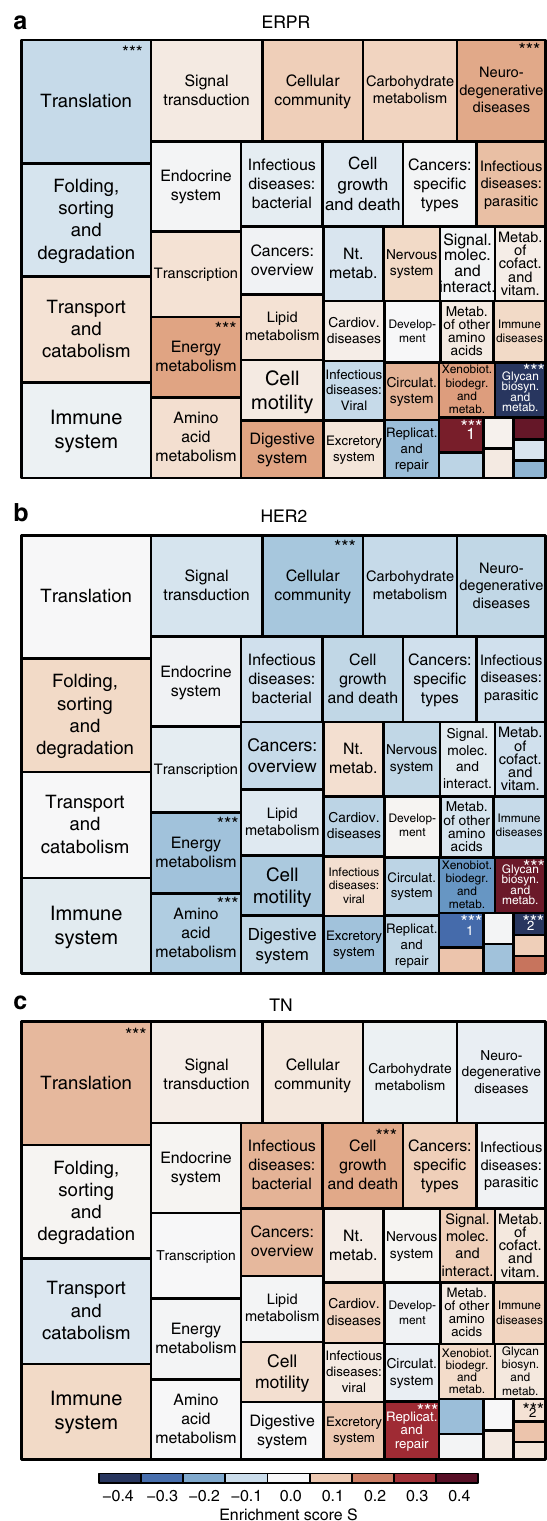
Infectious diseases: parasitic